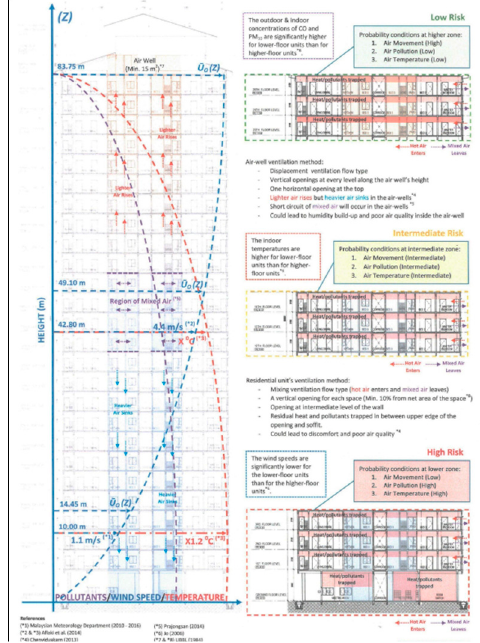
Figure 3. Probabilities of air temperature, wind speed and pollutants concentration in high-rise residential building.